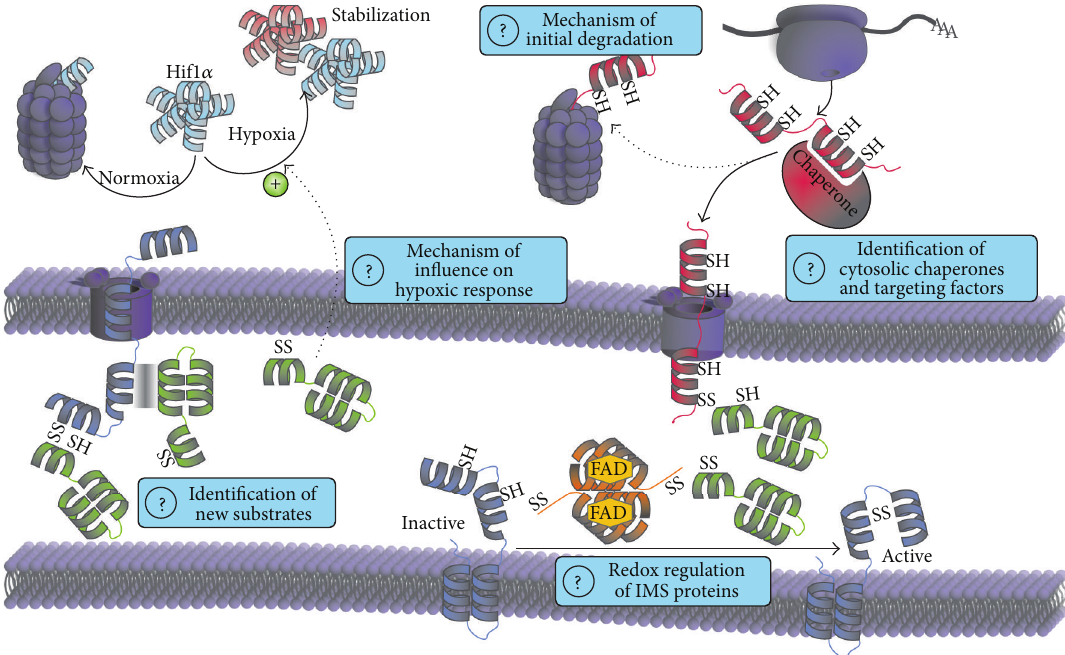
Figure 5: Open questions. Hypoxia. Why Mia40 is required for the stabilization of HIF1 𝛼 under hypoxic conditions is unknown. It will be interesting to reveal the underlying mechanism and if the influence of Mia40 is direct or indirect. New Substrates. During the last years proteins were found to be dependent on Mia40 that do not share the same motifs as the classical twin-CX 9 C and twin-CX 3 C substrates. They are either dependent on the function of Mia40 as oxidoreductase or holdase. Initial Degradation and Cytosolic Chaperones/Targeting Factors. In yeast a portion of IMS proteins is directly degraded after translation. However, it is not known if this takes place in other organisms, how it is regulated, and how it works at the molecular level. Moreover, it remains unclear how proteins after translation are kept import competent and targeted to mitochondria. Redox Regulation. The mitochondrial disulfide relay is known to introduce structural disulfide bonds which are required for protein stability. However, it is not known if Mia40 or Erv1/ALR can regulate the activity of IMS proteins by reversible oxidation or